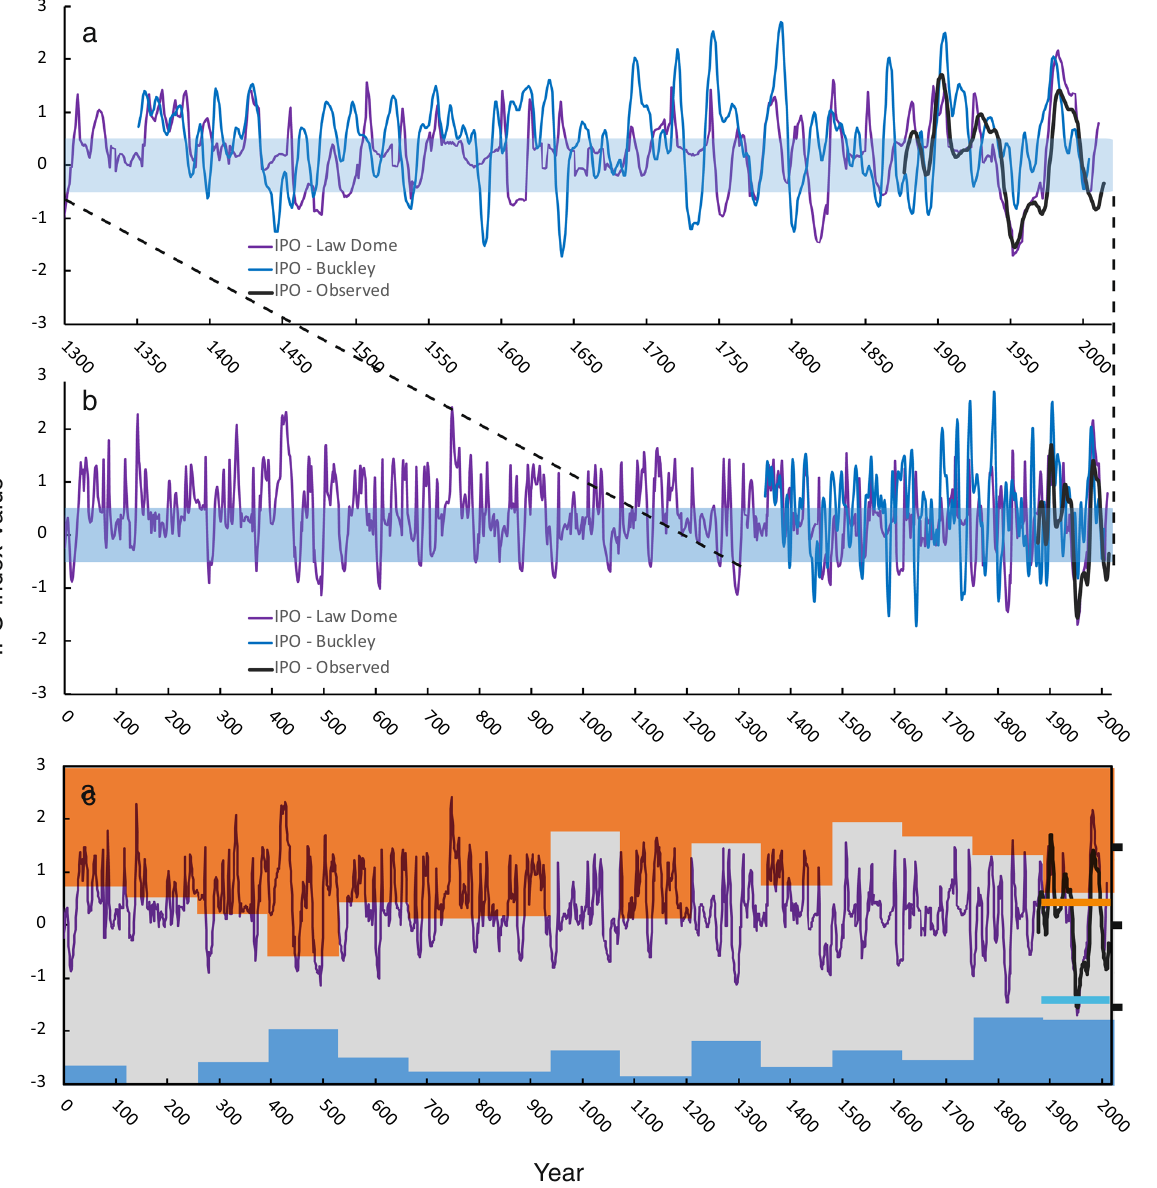
Fig. 2 Comparison between the two IPO reconstructions and observational record. The Buckley et al. reconstruction (1351 – 2004, blue) and the extended Law Dome reconstruction developed here (CE 1 – 2011, purple) are shown over their common period ( a ) and over the Common Era ( b ), with blue banding representing neutral IPO (0.5 to − 0.5). The lower panel of c shows the Law Dome reconstruction (purple) and instrumental record (black) over the Common Era with partitioning into phase proportions (positive, negative and neutral) in bands of 135 years (i.e. equivalent to the length of observations: 1877 – 2014, 1742 – 1876, 1607 – 1741, etc). The phase proportion partitioning illustrates the time spent in each phase for equivalent observations length epochs. Note the earliest partition spans 127 years (CE 1 – 127). Blue indicates the proportion of time in the negative phase, grey is neutral and orange is positive. Blue and orange lines in the instrumental era represent phase proportions according to the observed IPO (1877 – 2014, negative 28.3%, neutral 30.4% and positive 41.3%). Black tick marks to the right identify quartiles. For reference, the Buckley et al. reconstruction spans the fi ve recent 135 y bands and exhibits negative proportions of 10 – 14% and positive proportions of 47 –